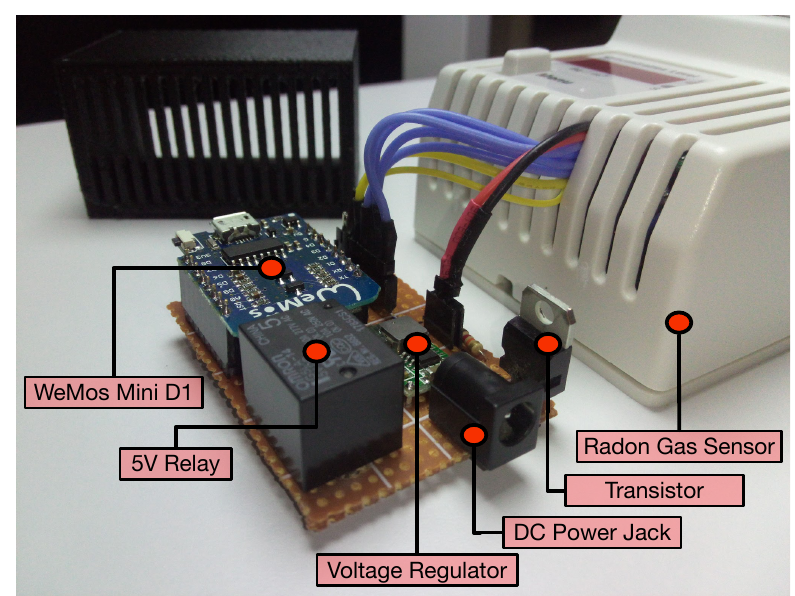
Figure 5. Components of the radon gas sensor.